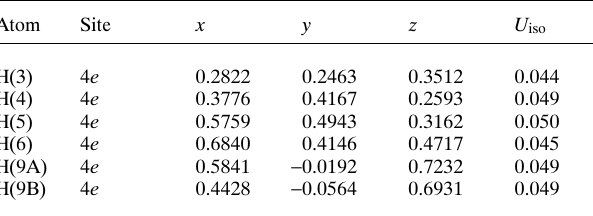
Table 2. Atomic coordinates and displacement parameters (in Å 2 )